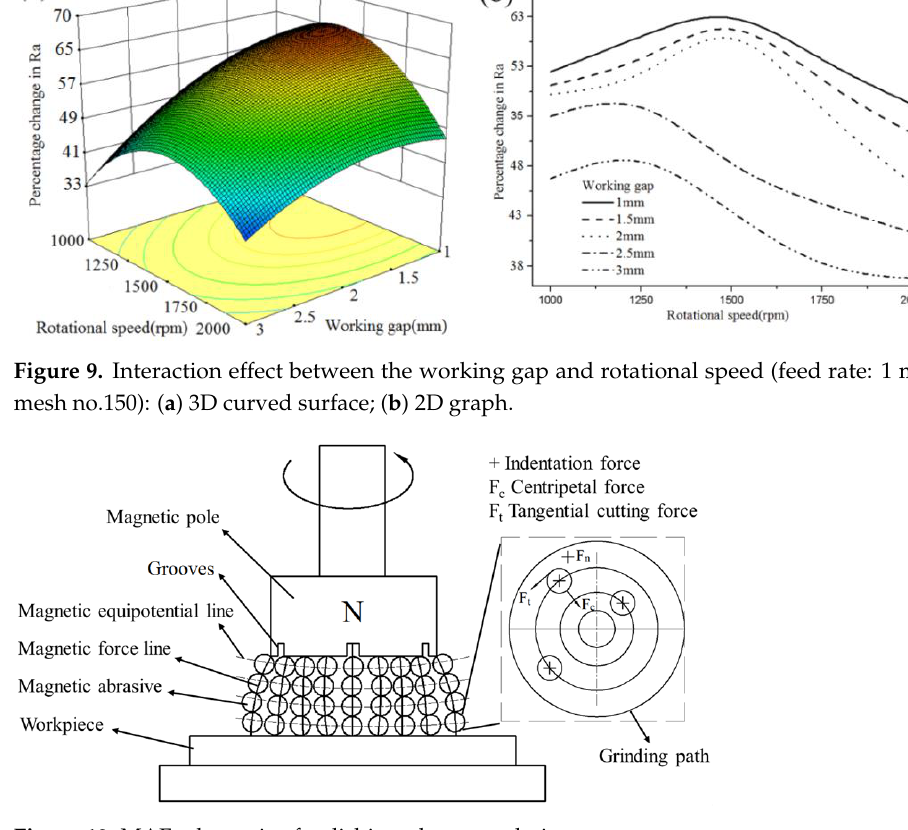
Figure 11. Interaction effect between the working gap and mesh number (feed rate: 1 mm/min; ro- tational speed: 1500): ( a ) 3D curved surface; ( b ) 2D graph.